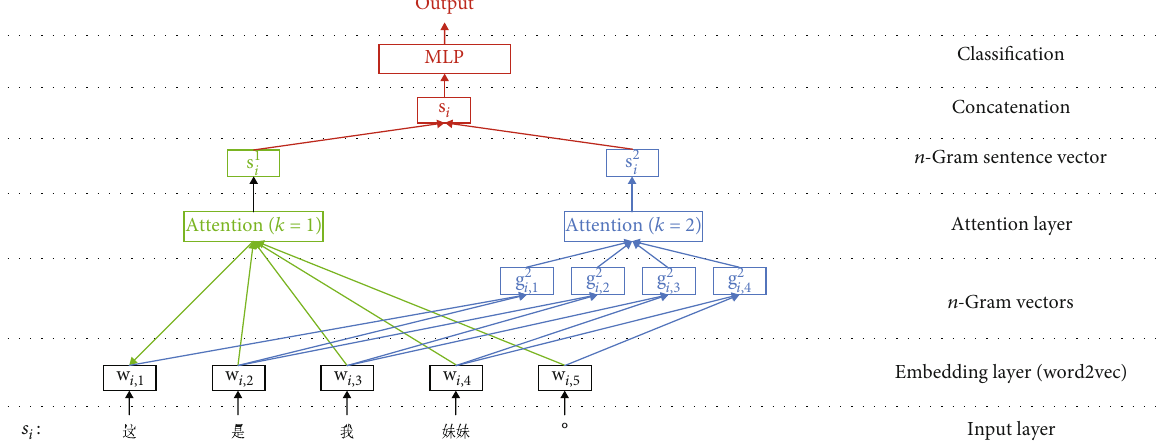
={ 这 是 我 妹妹 。 }. The embedding layer i g . Then, n -gram vectors come from the concatenation = f w , w , w , w , w i i ,1 i ,2 i ,3 i ,4 i ,5 g come from the concatenation of every two = f g 2 , g 2 , g 2 , g 2 i j ,1 j ,2 j ,3 i ,4 in the sentence s to obtain the score a 1 . Similarly, when k = 2 , i , j i i , j ð g 2 Þ by the weights a 1 ð a 2 Þ , we obtain the sentence in s is a 2 . Weighting the sum of all w i i , j i , j i , j i , j i , j i , j and s 2 are concatenated together to get the sentence vector s , which is the input to the MLP i i i